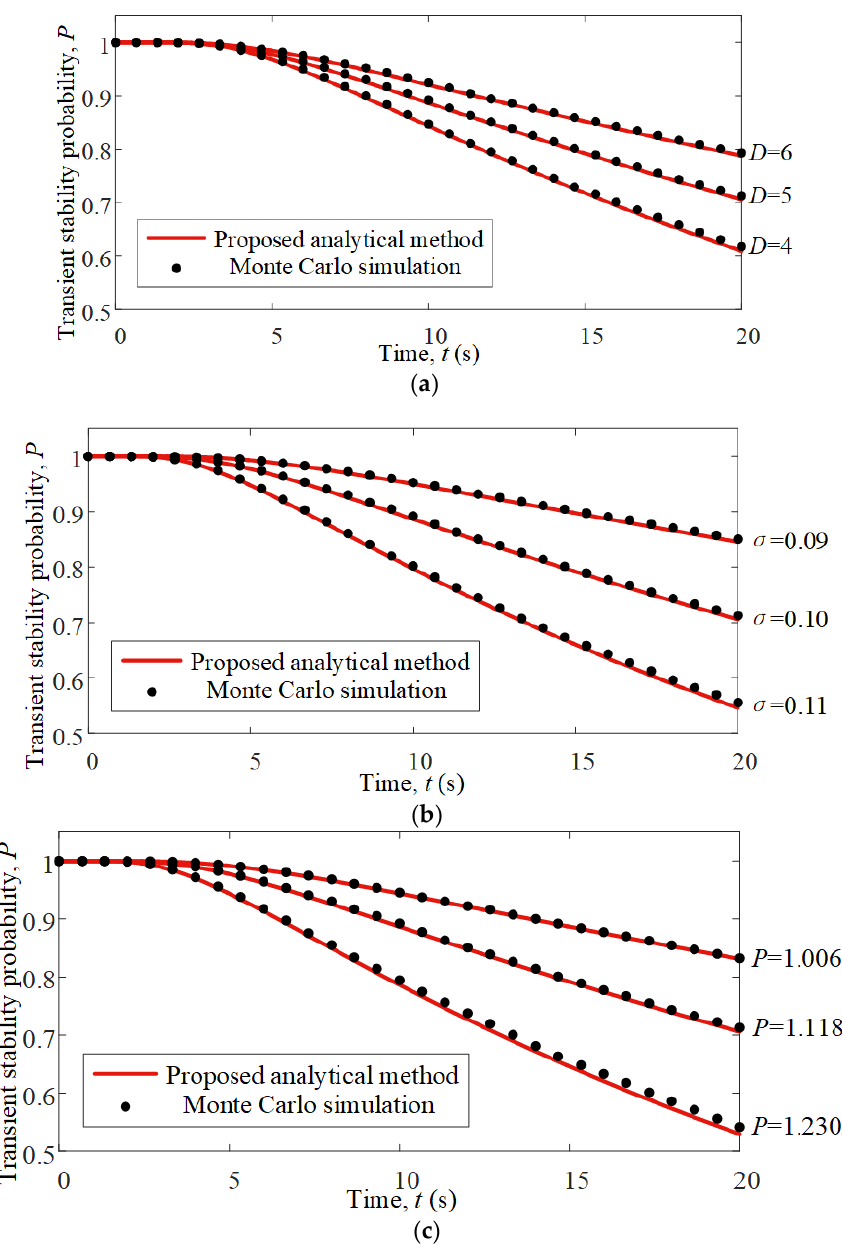
Figure 5. Stability probability of power system with losses under stochastic continuous disturbances: ( a ) damping coefficient; ( b ) intensity of stochastic continuous disturbances; ( c ) mechanical power.